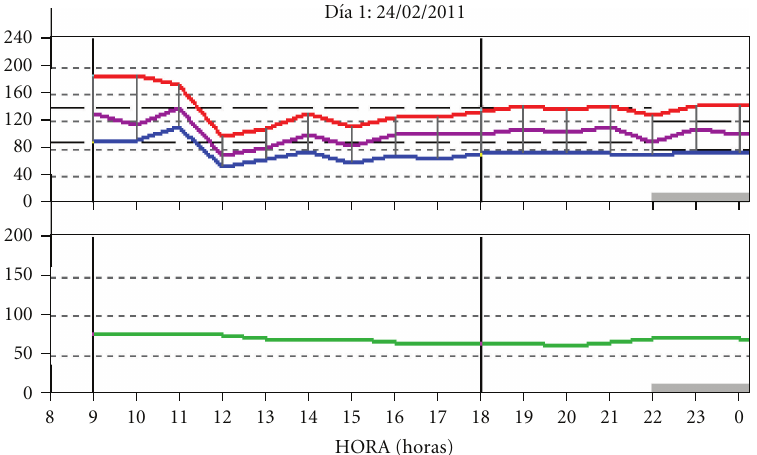
Figure 2: Patient of 79 years old with hypertension and diabetes. Combined therapy with 4 antihypertensive agents. Hypotensive